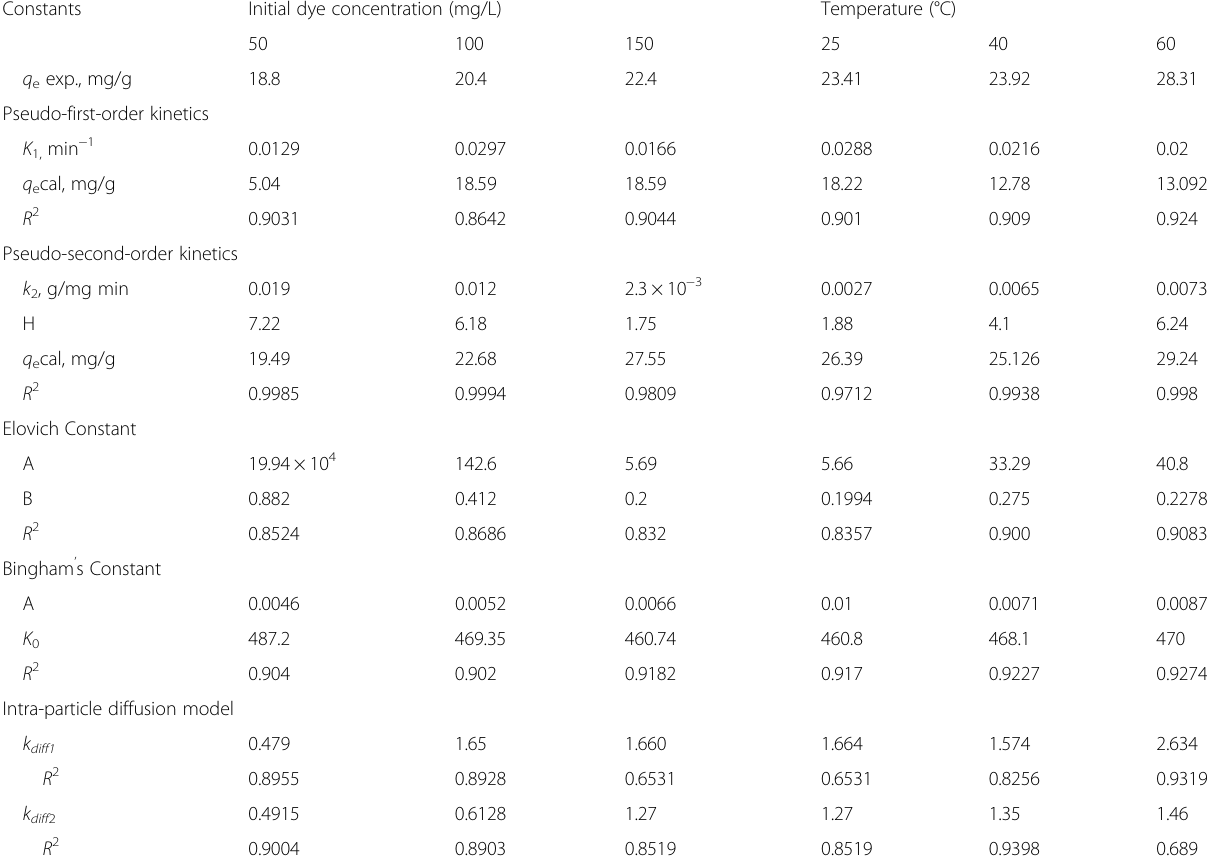
Table 1 Summary of the constants of different kinetic models for adsorption of AO67onto RPSF at different concentrations and different temperatures